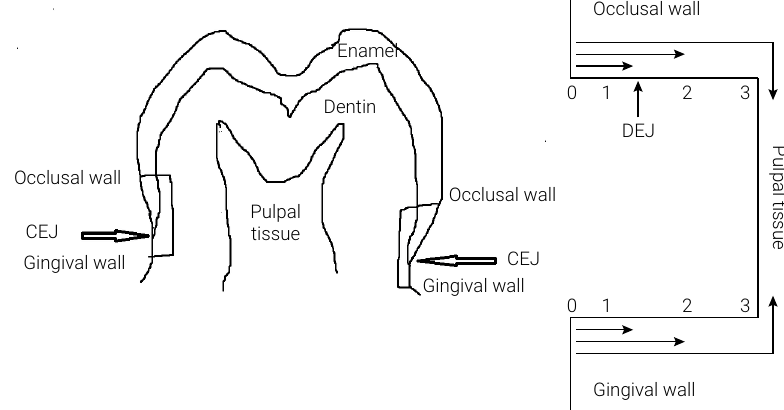
Figure 1. Schematic view of the cavity prepared in the buccal and lingual walls of a molar tooth. The maximum degree of dye penetration was recorded according to the followiing scoring system :0, no dye penetration; 1, dye penetration to 1/3 of the cavity wall; 2, dye penetration up to 2/3 of the cavity wall, 3, dye penetration extending to the axial wall and beyond. CEJ: Cementoenamel junction; DEJ: Dentinoenamel